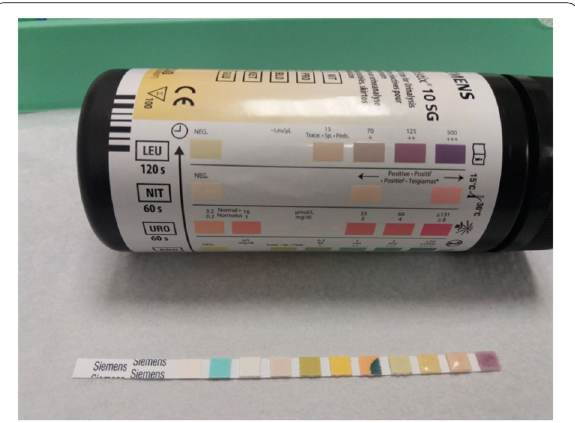
Fig. 1 Positive leukocyte esterase test (LET): Please note the first test strip on the right hand side; it has turned purple after 2 min which equals LET according to the scale on the box above the + + +